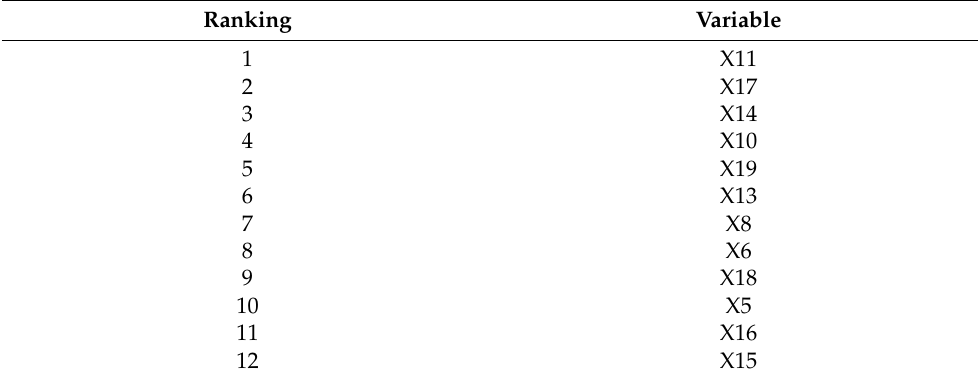
Table 16. Ranking of feature importance by mean SHAP values.